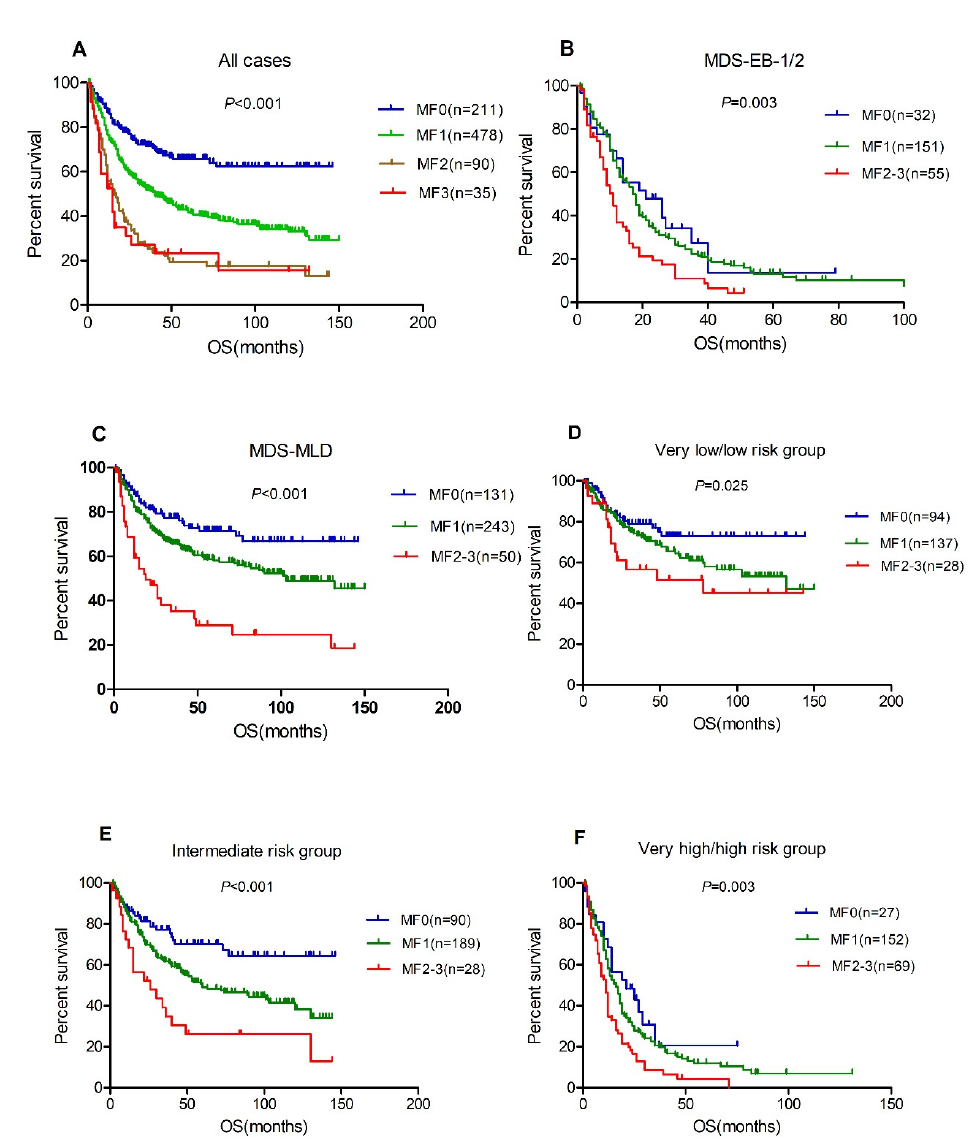
Figure 2. BM fibrosis associated with inferior overall survival. ( A ), total patients, n = 814; ( B ), MDS-EB-1 and 2, n = 238; ( C ), MDS-MLD, n = 424; ( D ), very low/low risk group; ( E ), intermediate risk group; ( F ), very high/high risk group.